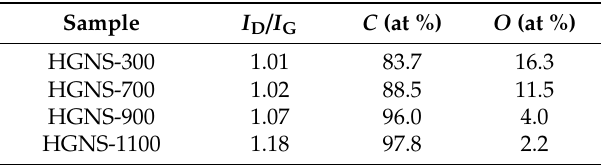
Table 1. Raman I D / I G ratio and chemical compositions of various HGNS samples evaluated using an elemental analyzer.